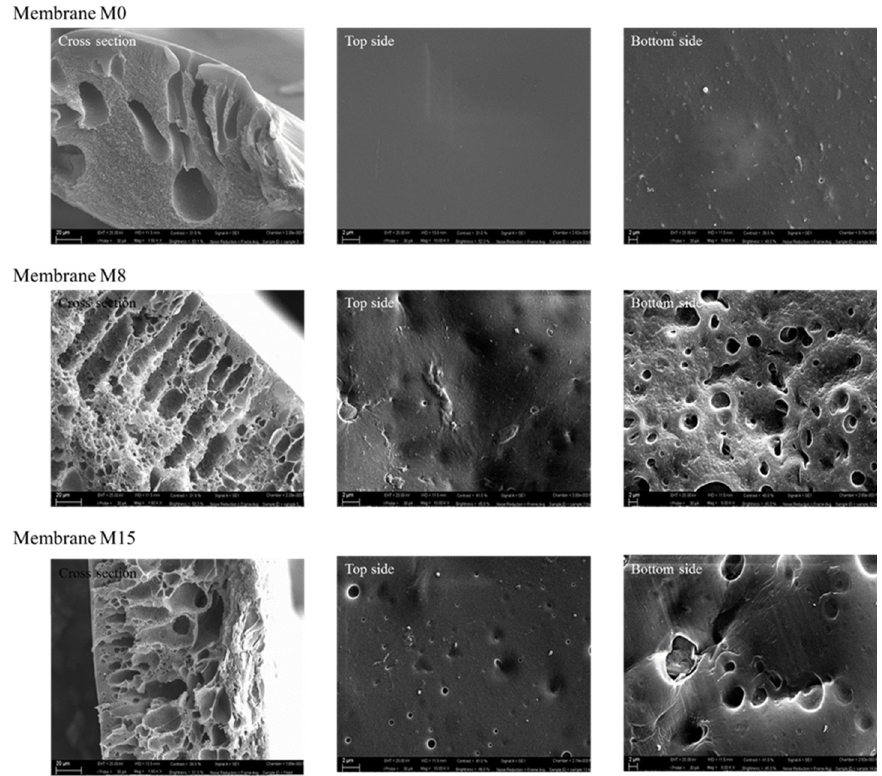
Figure 3. SEM images of neat membrane M0 and the blended membrane M8 and M15 with Magnification of 150× (cross-section), 1000× (top surface) and 5000× (bottom surface).